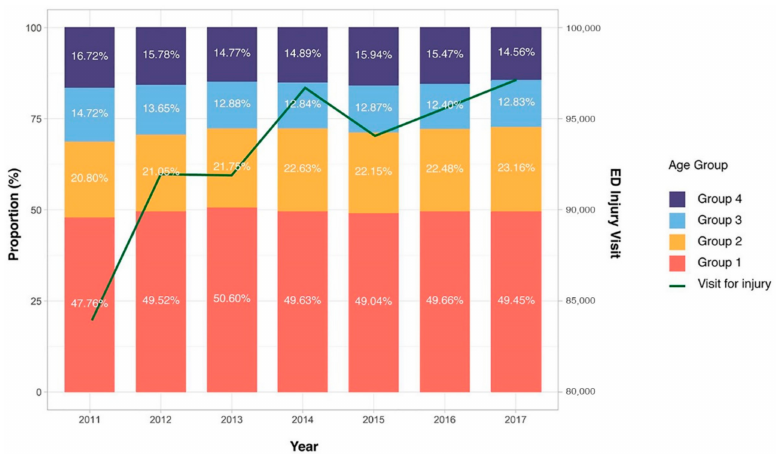
Figure 1. Proportion of emergency department (ED) visits for injury by age group during 2011–2017.